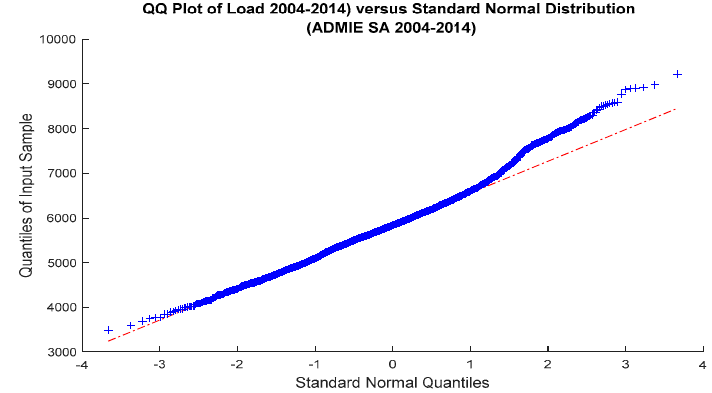
Figure 7. The Q ‐ Q plot of load series, indicating a deviation from normality at right tail.